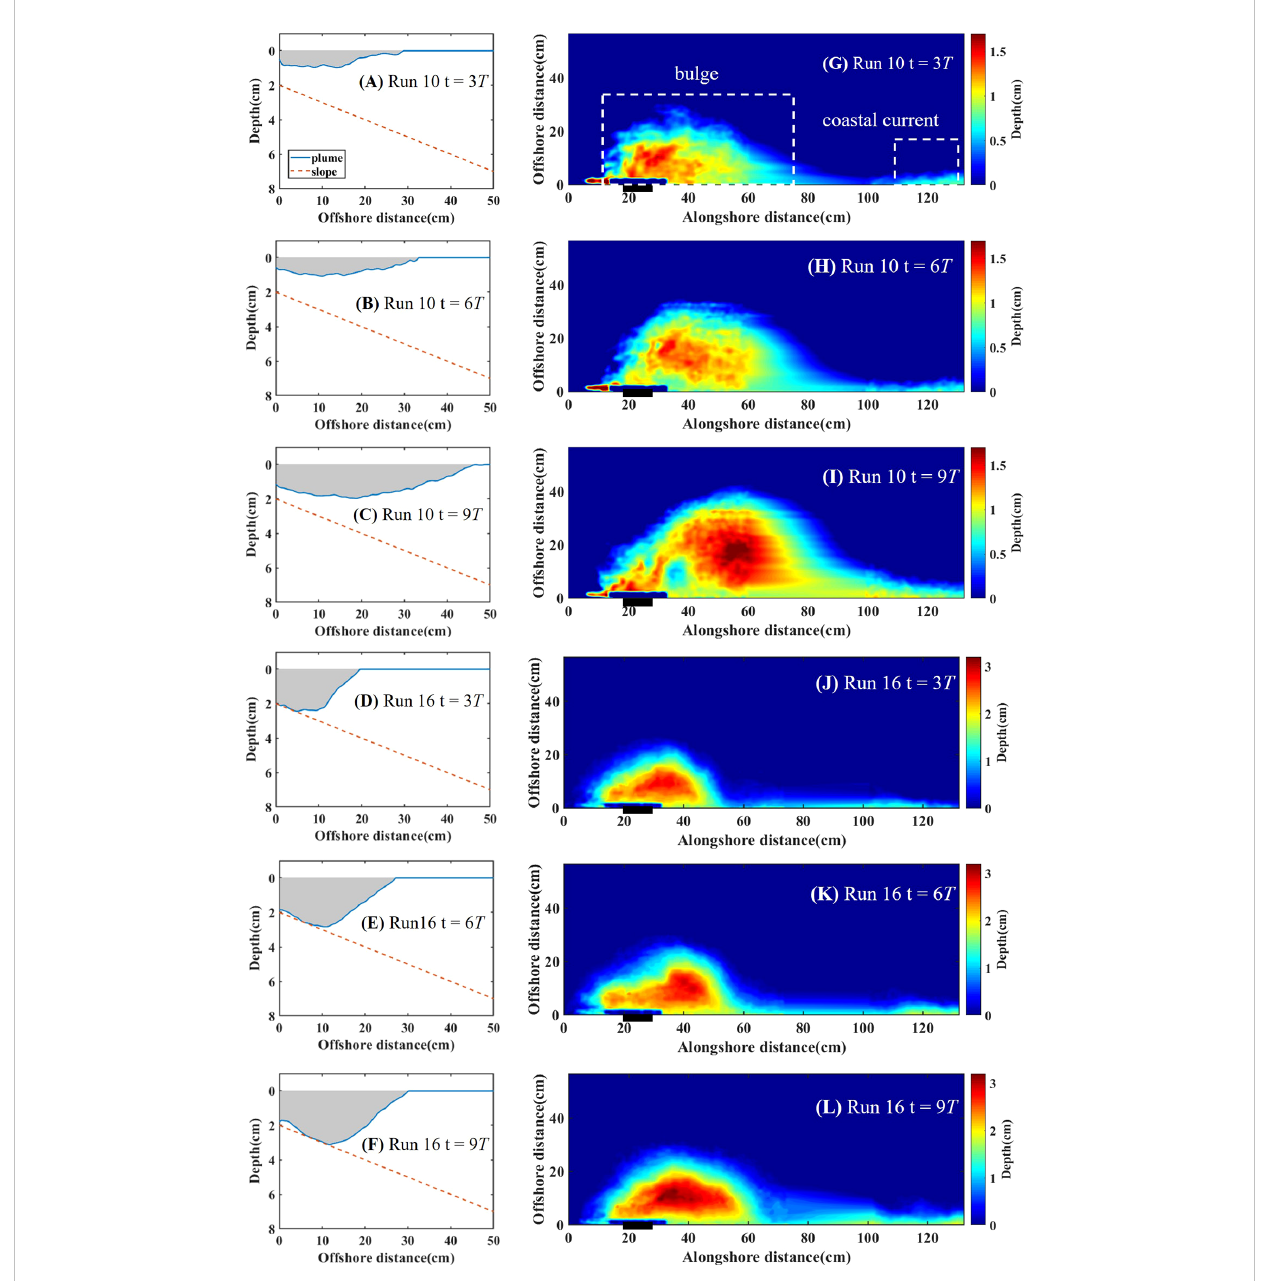
FIGURE 4 (A – F) Side-view of the interaction of plume and the bottom slope. The blue line and red dash line indicate plume contour and the sloping bottom. (G – L) Plume thickness fi eld. The white dash boxes indicate bulge region and coastal current region. The top six panels are the example of surface- advected plume (run 10) with t = 3 T (A, G) , 6 T (B, H) , and 9 T (C, I) , while the bottom six panels are the example of bottom-attached plume (run 16) with t = 3 T (D, J) , 6 T (E, K) , and 9 T (F, L)